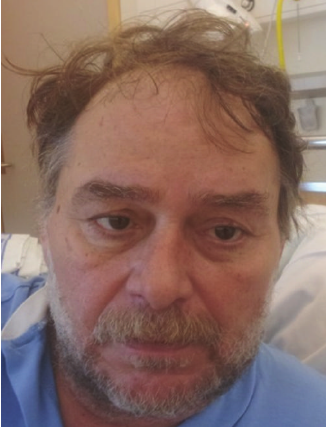
Figure 1: The patient with dysconjugate eye position.